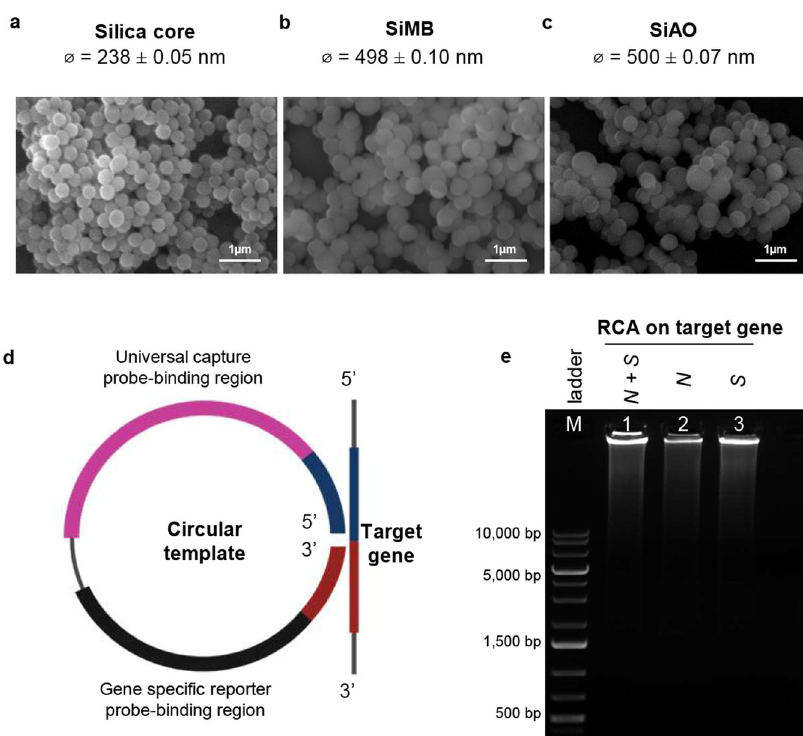
Fig. 2 Visualization of the silica-redox dye and RCA amplicons. a SEM image with 1 µ m scale bar of silica core, b silica-methylene blue (SiMB), and c silica-acridine orange (SiAO) composite particles with diameter sizes ( ϕ ) which are presented as mean values ± standard deviation (SD), n = 10. d Target gene, universal capture probe, and gene-speci fi c reporter probe binding regions on the circular DNA template. e Gel representation of RCA amplicons visualized on 0.8% agarose gel electrophoresis ( n = 3). Lane M indicates the 1 kb DNA ladder, while lanes 1, 2, and 3 indicate the RCA amplicons of both N and S genes, N gene only, and S gene only, respectively. Source data are provided as a Source Data fi